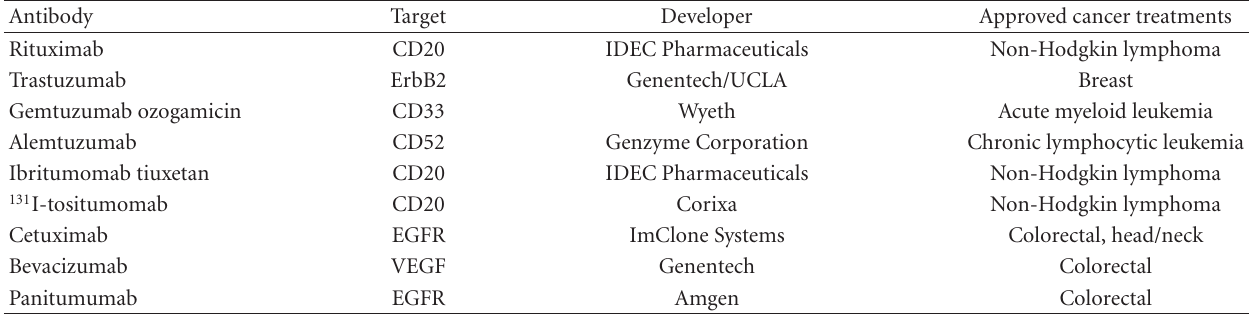
Table 2: FDA approved monoclonal antibodies for use in cancer